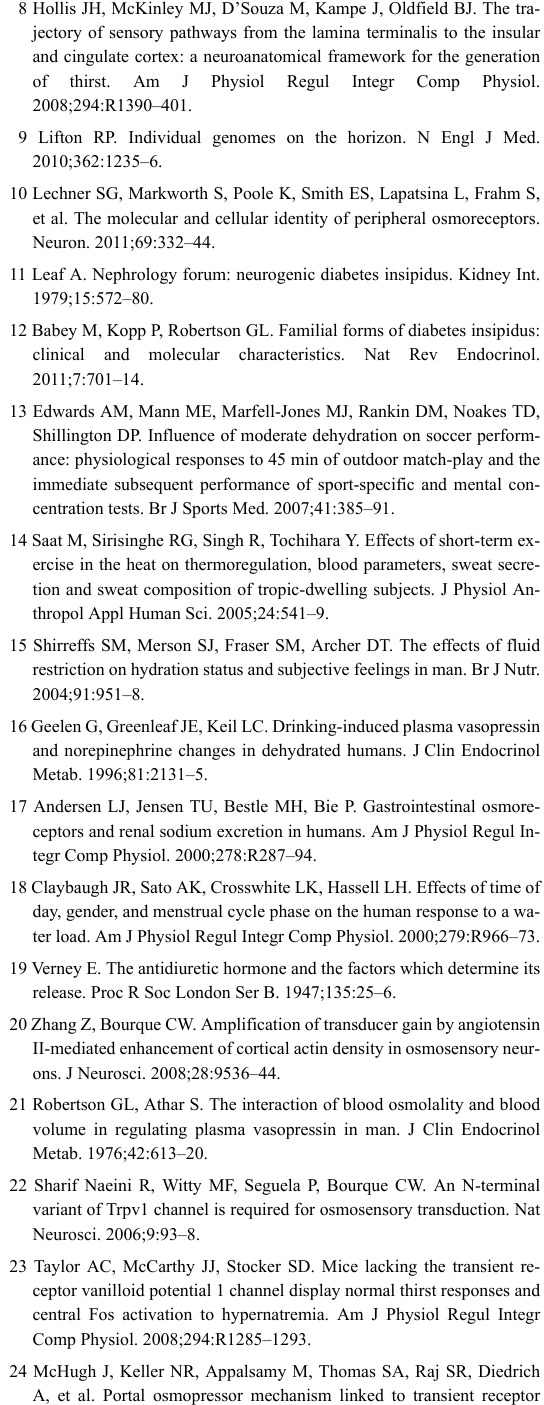
↓ Hereditary nephrogenic diabetes insipidus